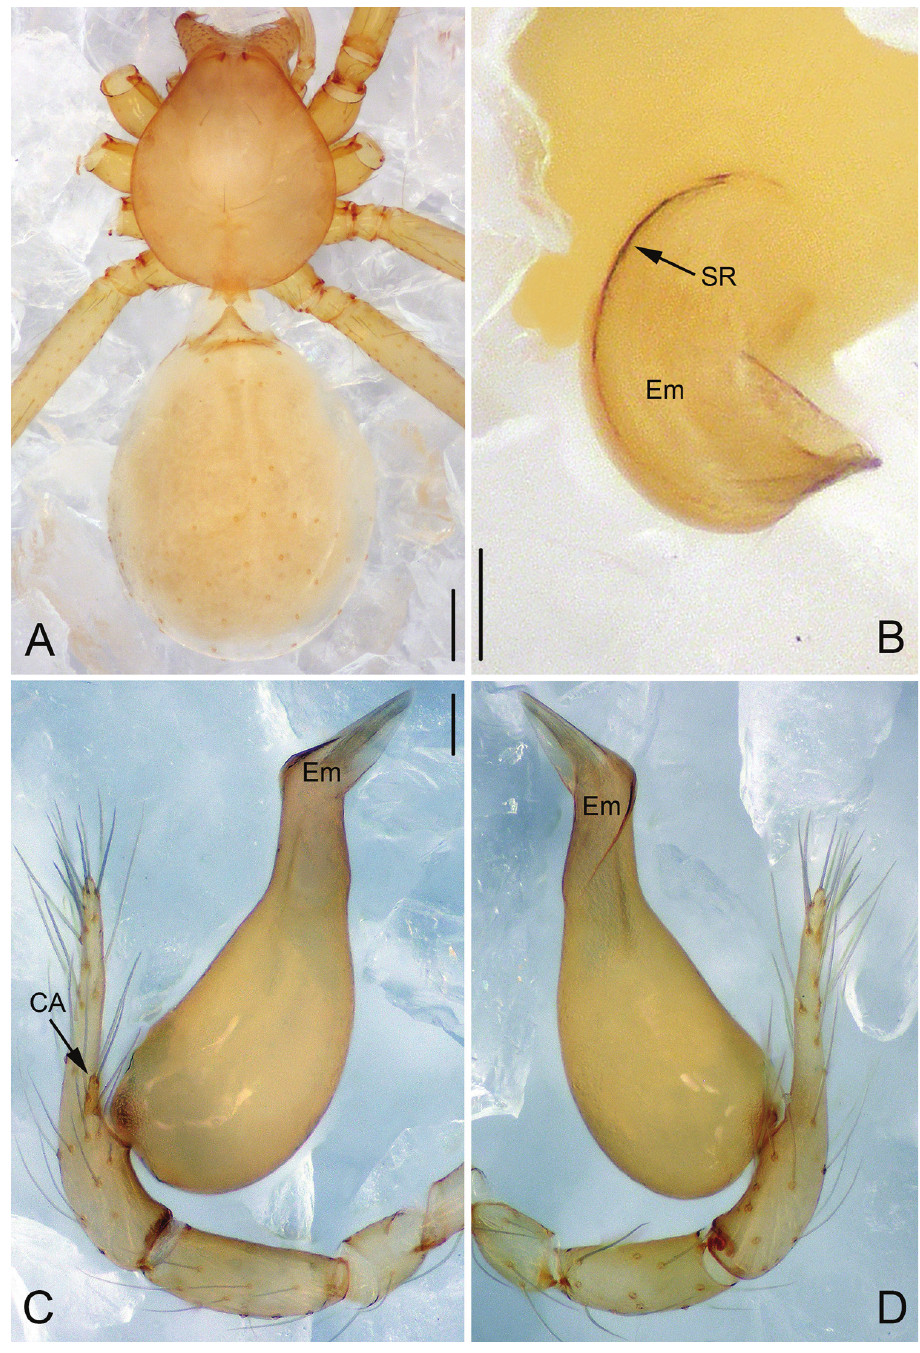
Figure 5. Pinelema qingfengensis sp. n., male holotype. A Habitus, dorsal view B Tip of embolus, apical view C Palp, prolateral view D Palp, retrolateral view. Scale bars: 0.2 mm ( A ), 0.05 mm ( B ), 0.1 mm ( C–D